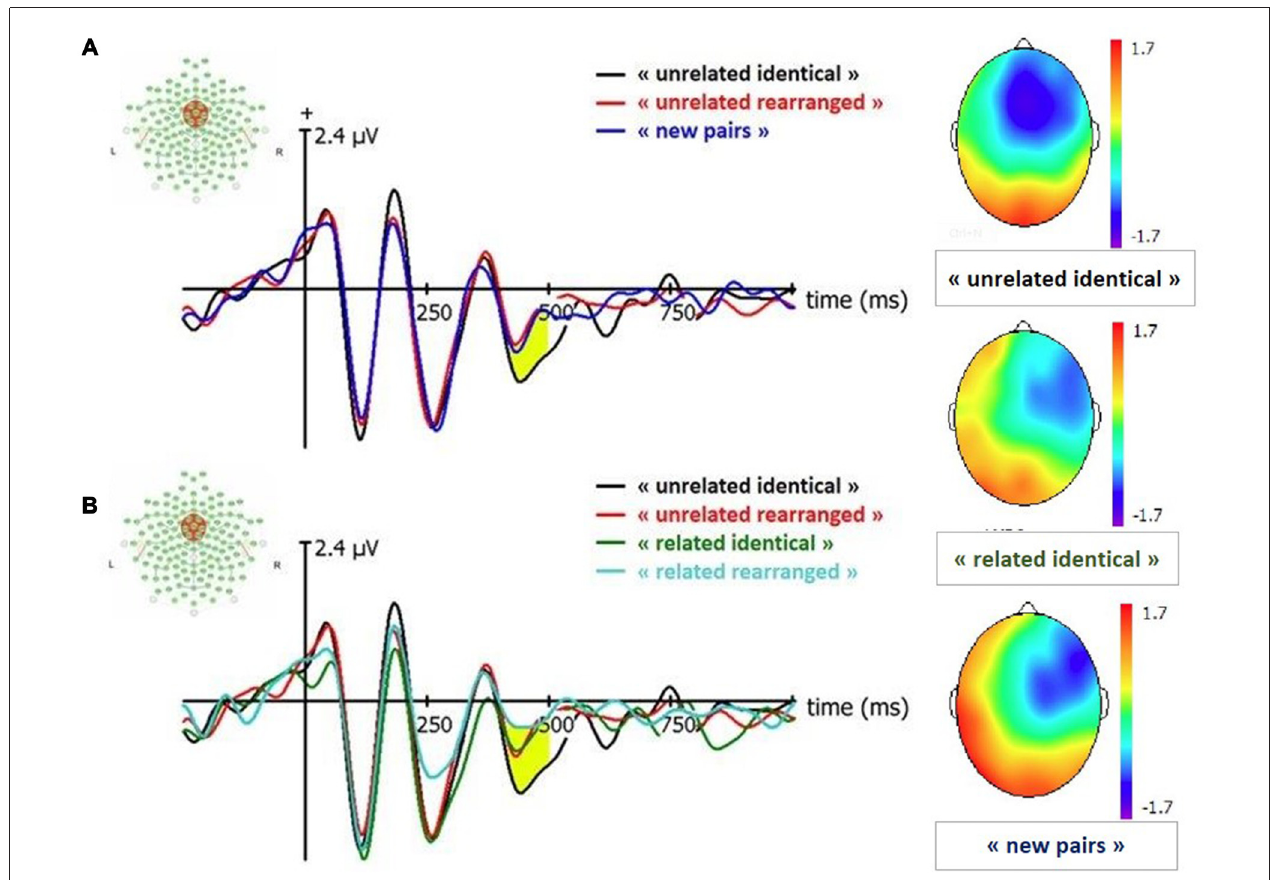
FIGURE 4 | Event-Related Potentials (ERP) and topographies for FN400 (signal in Cz between 420–500 ms). “related identical”: semantically related identical pairs; “related rearranged”: semantically related rearranged pairs; “unrelated identical”: semantically unrelated identical pairs; “unrelated rearranged”: semantically unrelated rearranged pairs; “new pairs”: semantically unrelated new pairs. (A) Old/New effect for unrelated pairs. (B) Effect of semantic factor on Condition. Yellow shaded areas correspond to significant differences between